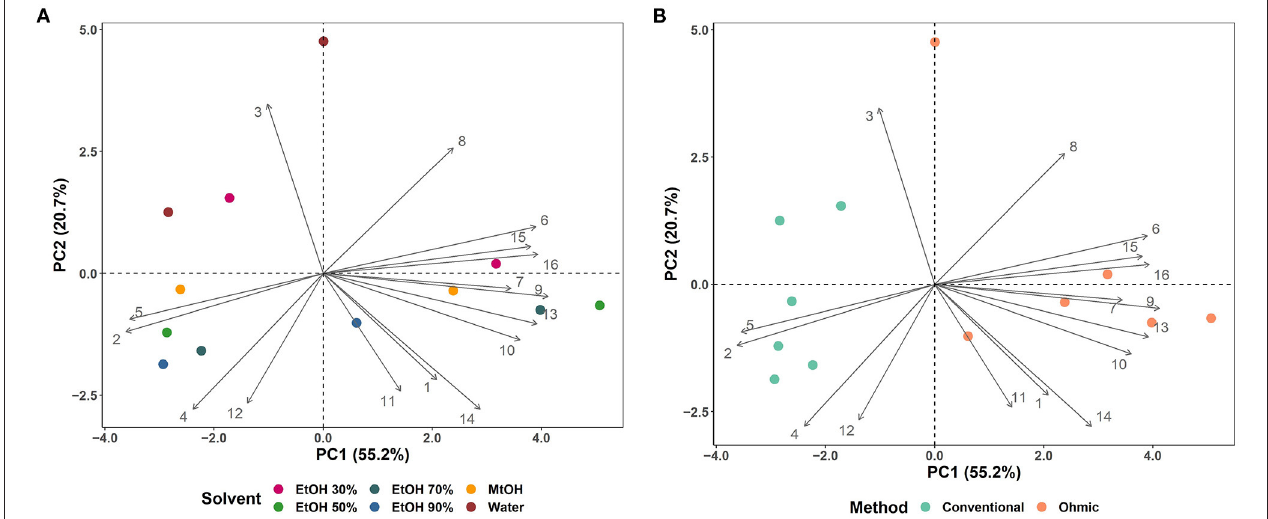
FIGURE 3 | Principal component analysis (PCA) on the obtained extracts from Red eggplant. (A) Phenolic compounds distribution of extracts obtained by different solvents; (B) phenolic compounds distribution of extracts obtained by different extraction methods. 1 - Kaempferol; 2 - Chlorogenic acid; 3 - Syringic acid; 4 - Cinnamic acid; 5 - Caffeic acid; 6 - p -coumaric acid + epicatechin; 7 - o -coumaric acid; 8 - Rosmarinic acid; 9 - Ellagic acid; 10 - Naringin; 11 - Hesperidin; 12 - Apigenin; 13 - Gallic acid; 14 – Resveratrol; 15 - Ferulic acid; 16 -